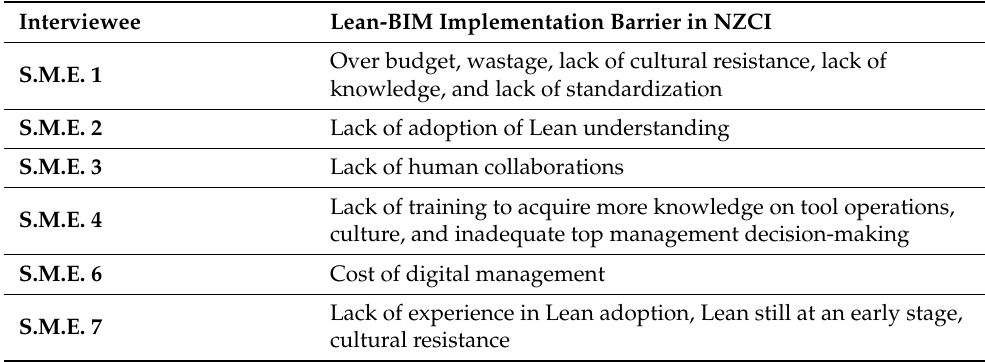
Table 7. S.M.E.-identified barriers to Lean-BIM implementation in